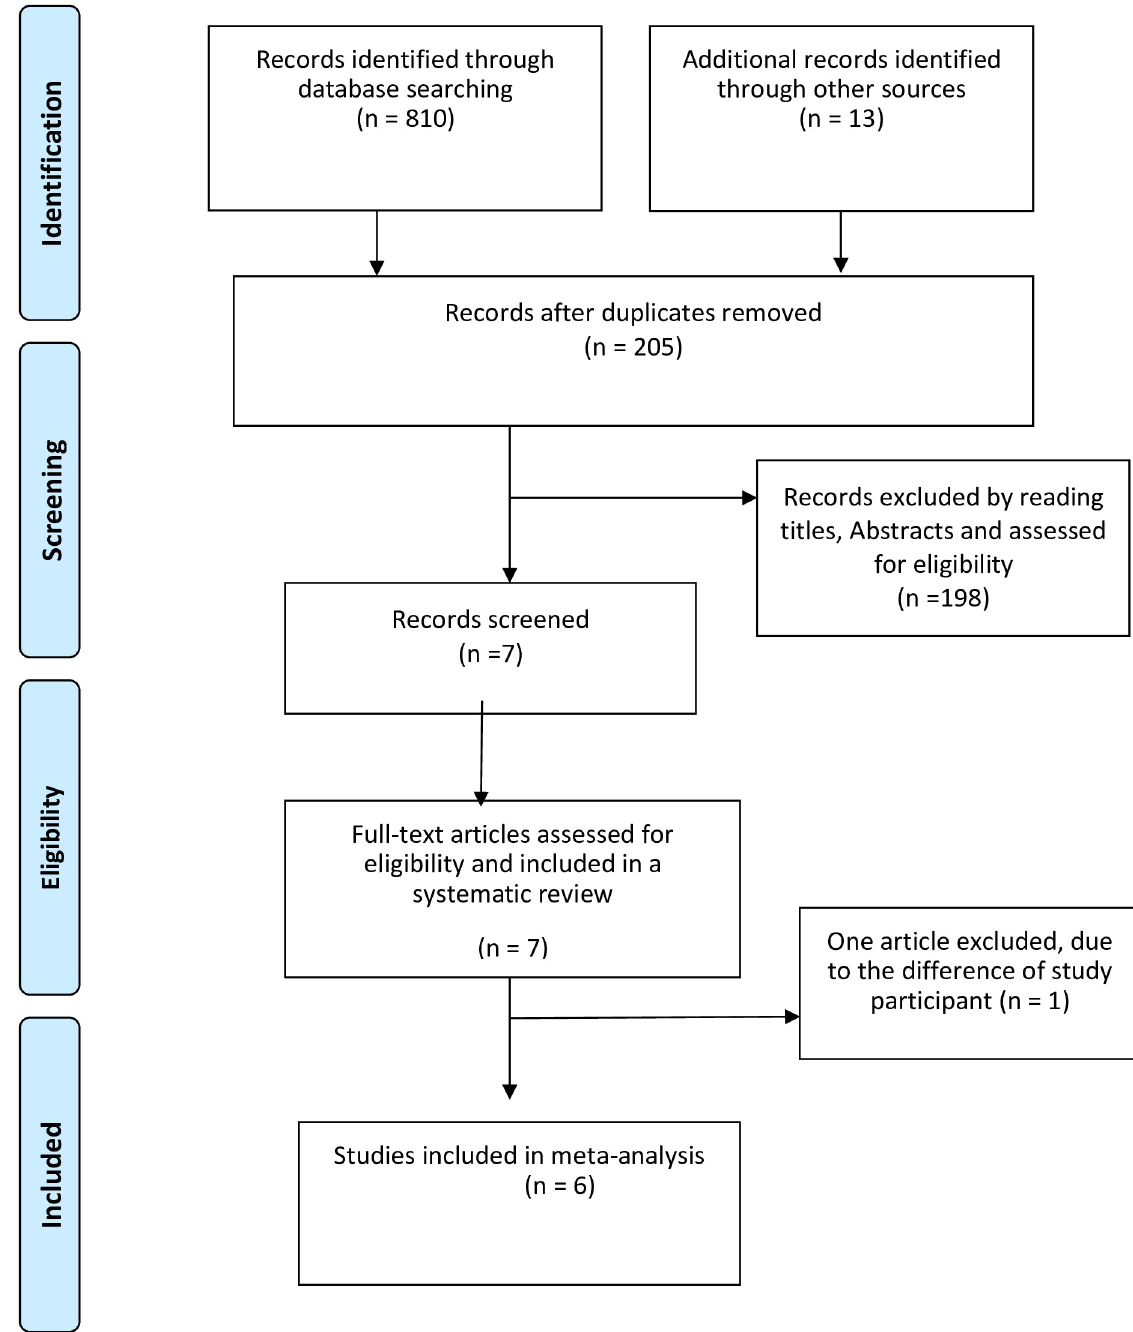
Fig 1. The PRISMA flow diagram of identification and selection of studies for the systematic review and